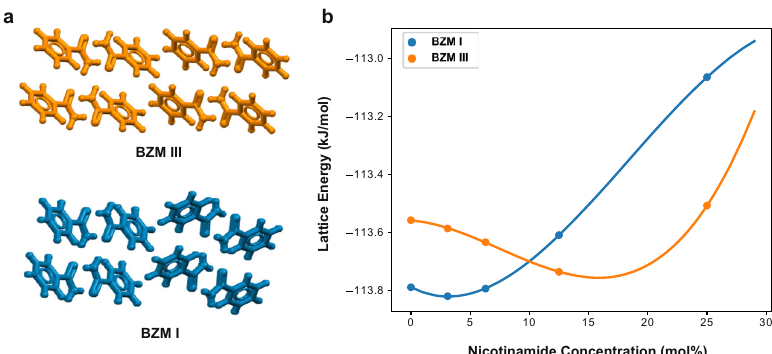
Fig. 2 Impact of nicotinamide content on the stability of benzamide forms I and III. a Crystal packing of BZM form I (blue) and BZM form III (orange); ( b ) Lattice energies of forms I (blue) and form III (orange) BZM as a function of the NCM concentration. Circles correspond to models for which lattice energies have been calculated (Supplementary Methods 1.3) whilst lines correspond to polynomial fi ts to the calculated energies - added to aid the eye.